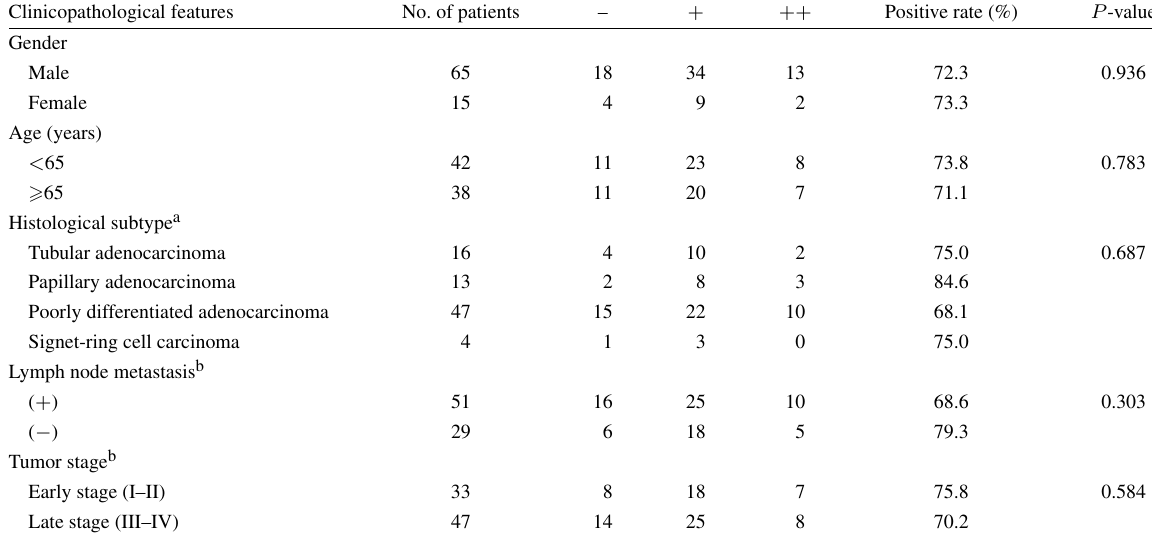
Relationship between E2F-1 protein expression and clinicopathological features of gastric carcinoma